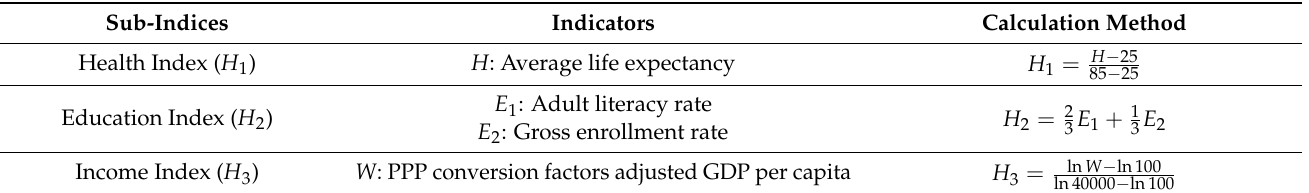
Table 2. HDI calculation.